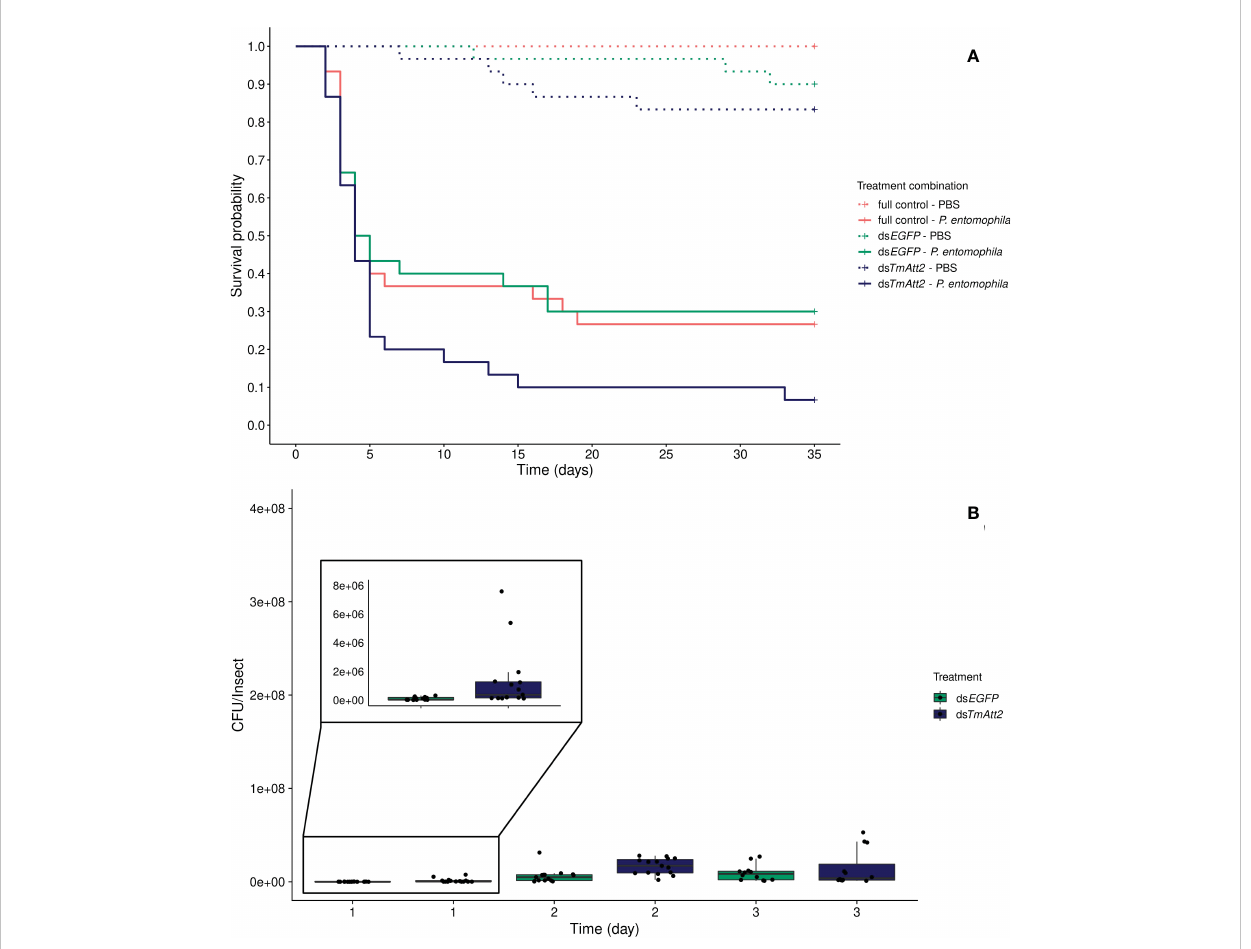
FIGURE 3 (A) Effect of TmAttacin2 ( TmAtt2 ) knockdown on survival of Pseudomonas entomophila infected Tenebrio molitor females over 35 days. ds EGFP was injected as a negative control for the nonspeci fi c effects of dsRNA and the third group includes dsRNA untreated control. Two independent experiments each performed on 15 females per treatment group. Each dsRNA-treated or dsRNA-untreated groups were infected with P. entomophila on day 3 after dsRNA treatment based on the data on knockdown ef fi ciency (Figure S9). Pink dashed line: Full control-PBS; Turquoise dashed line: ds EGFP - PBS; Navy blue dashed line: ds TmAtt2 - PBS; Pink line: Full control - P . entomophila ; Turquoise line: ds EGFP - P . entomophila ; Navy blue line: ds TmAtt2 - P . entomophila . (B) Bacterial load in ds TmAtt2 -silenced T. molitor challenged with P. entomophila at 1-, 2-, and 3-day post-infections. The colony-forming units (CFU) recovered from tissues of T. molitor females from ds TmAtt2 (navy blue) and ds